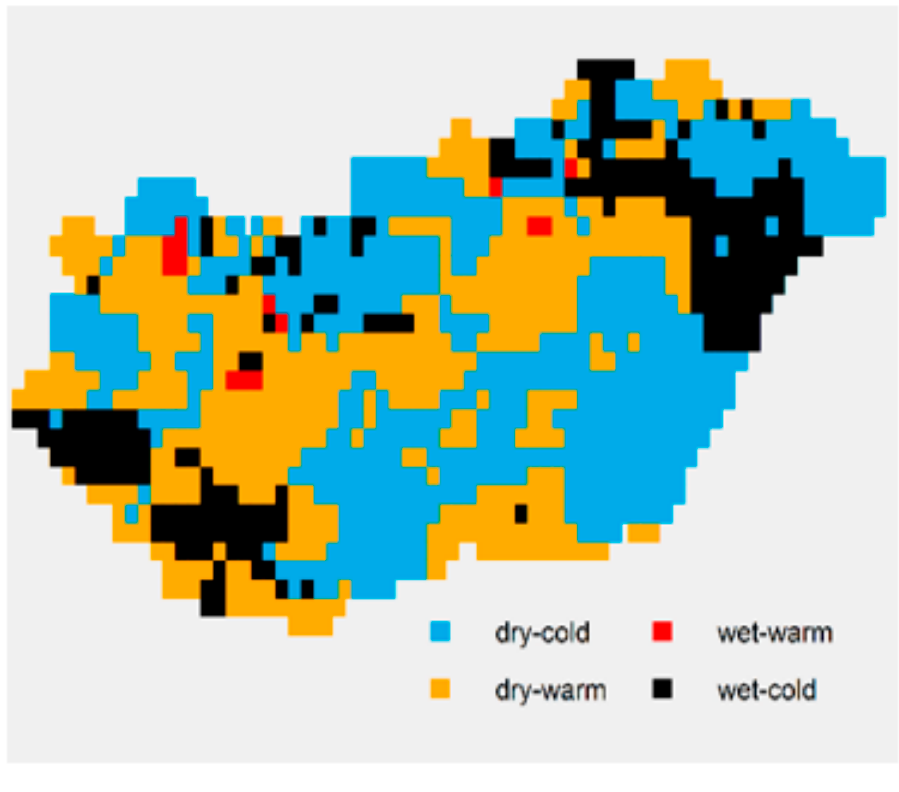
Figure A12. Characteristics of extreme months (July).